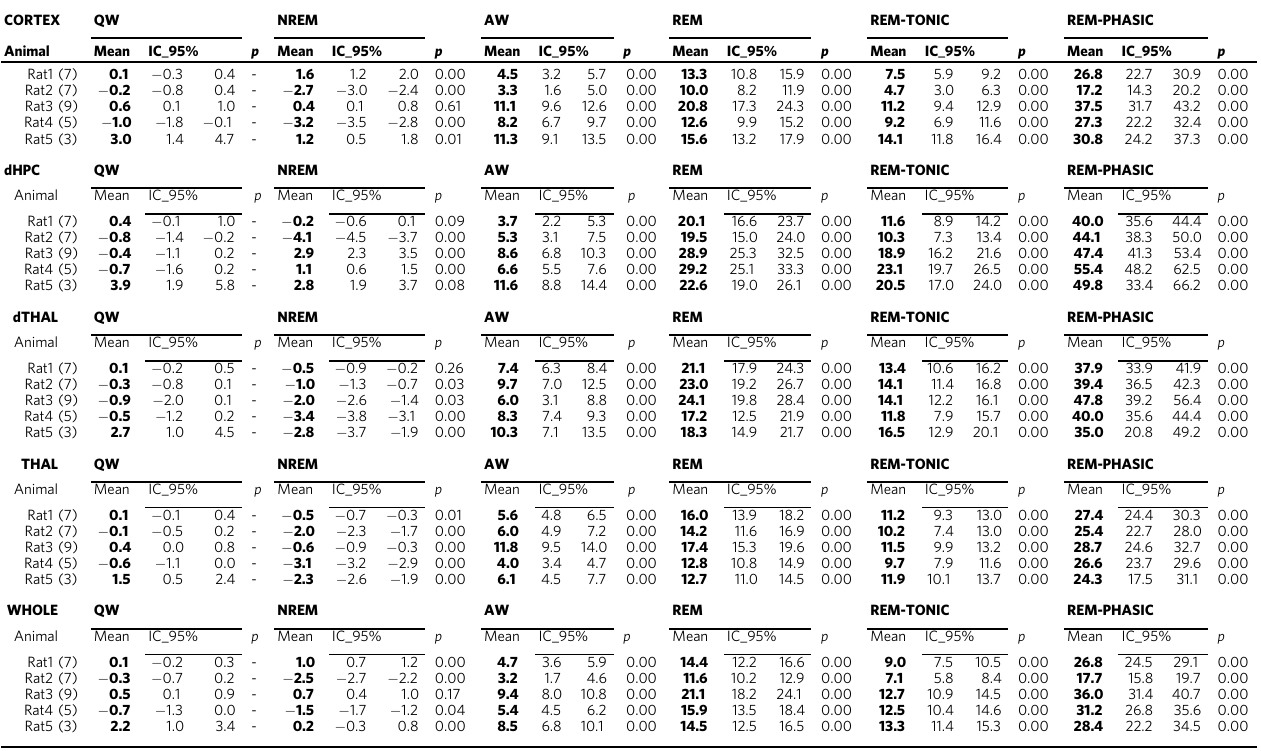
The analysis is performed for fi ve brain regions: cortex, dorsal Hippocampus (dHpc), dorsal Thalamus (dThal), Whole Thalamus (Thal), and Whole-brain (Whole). For each brain region, one row represents a single animal (the correspondingnumber of recordingsis given betweenbrackets)and a setof four columns corresponds to a single sleep state. For each sleep state, the left (bold) number is the mean CBV level, the second and third fi gures are the 95% con fi dence interval and the last value is the corresponding p -value for the observed sleep state to be drawn from the QW distribution. CBV levels are expressed in % of change relative to a baseline (3 fi rst minutes of